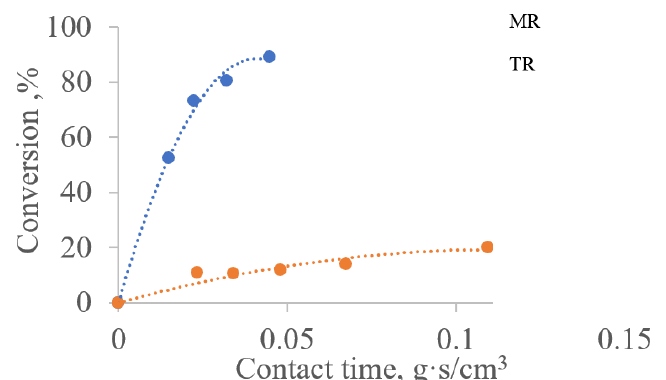
Figure 4. Dependence of the degree of methane conversion on the contact time for traditional and membrane reactors at a temperature of 850 °C:TR—reactor with a traditional catalyst; MR—reactor with membrane catalyst in diffusion transport mode.